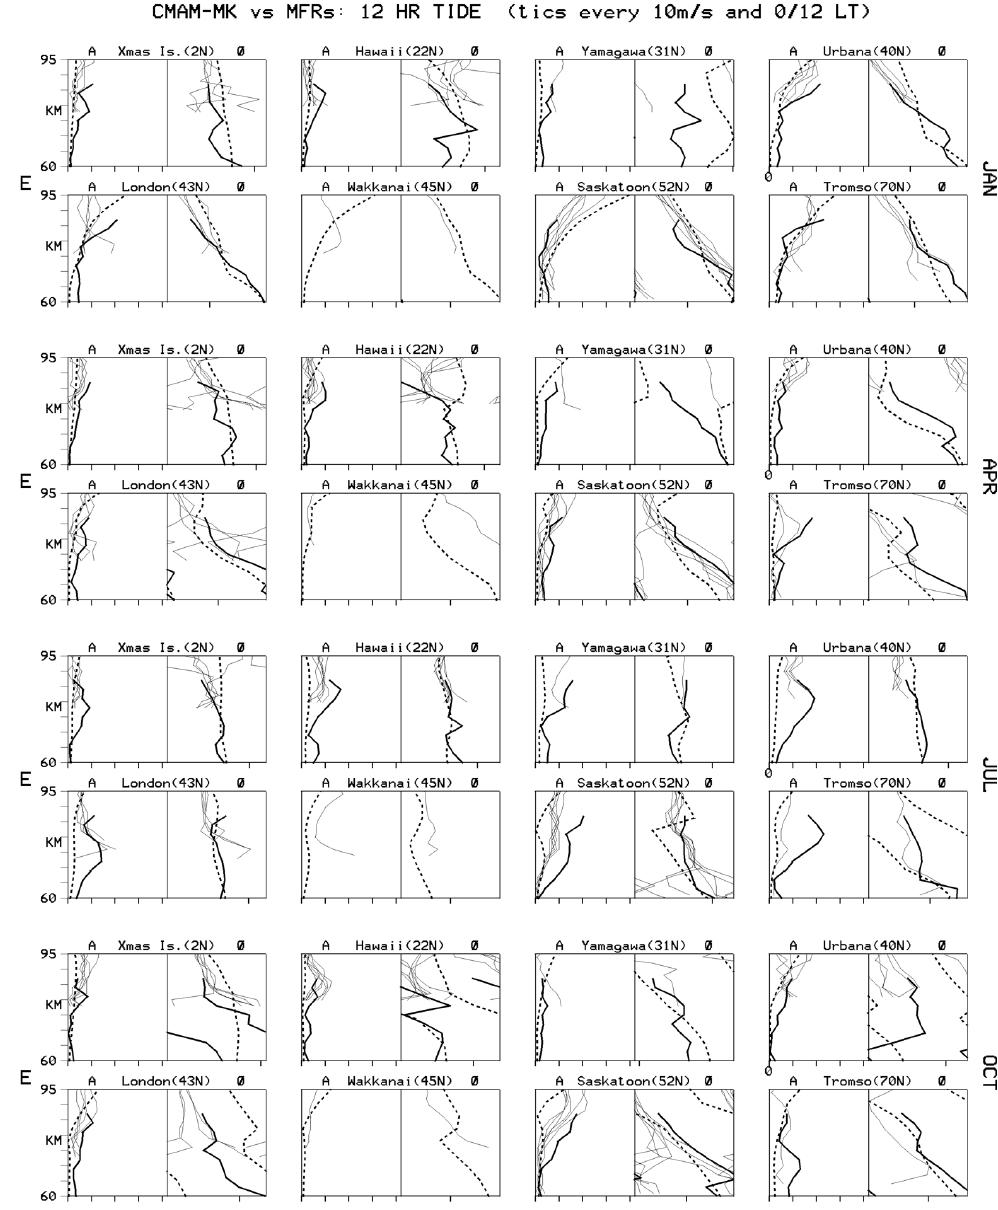
Fig. 11. Comparisons between profiles for the Semi-Diurnal (12h) Tide amplitudes and phases from the 8 MFR systems (thin lines), the Canadian GCM (CMAM) with the thick lines and the GSWM (thick dashed lines). The monthly means for winter, spring, summer and autumn (central) months are